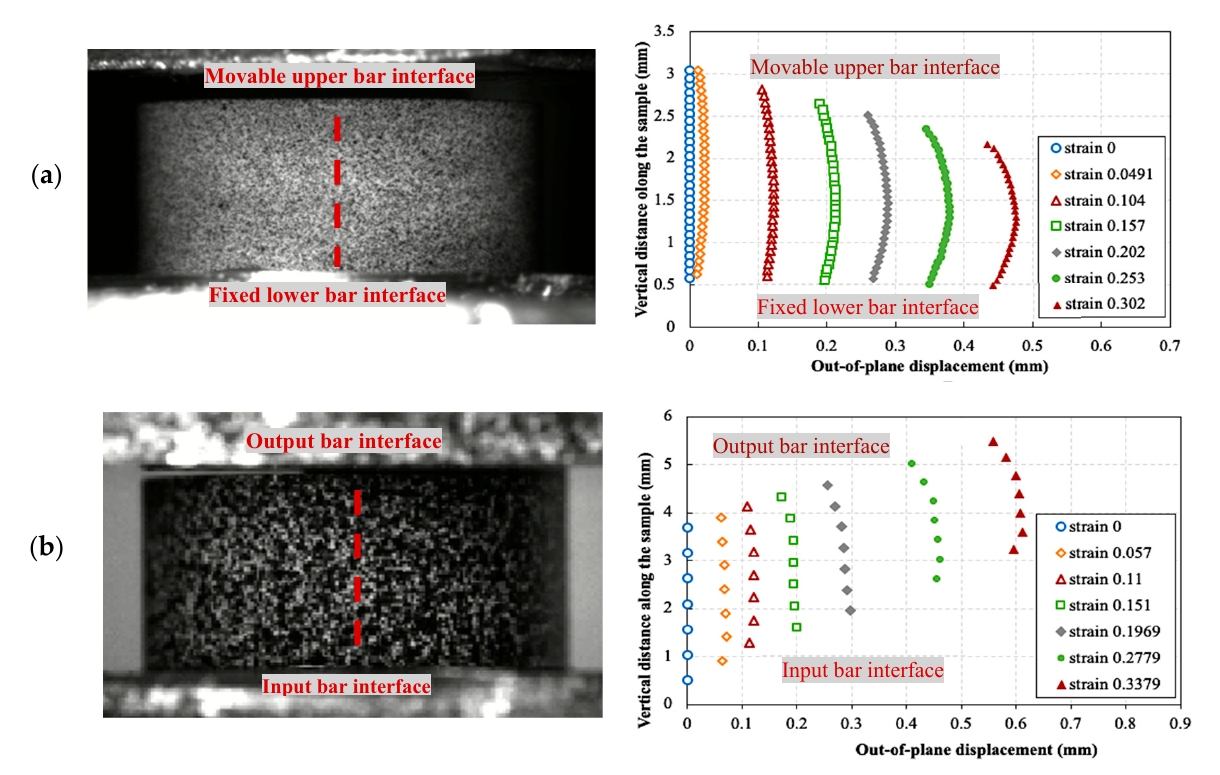
Figure 9. Out-of-plane (radial) displacement and vertical position of the vertical center line on the sample surface indicated in red at different levels of true axial strain: ( a ) during a quasi-static test, ( b ) during a high strain rate test.